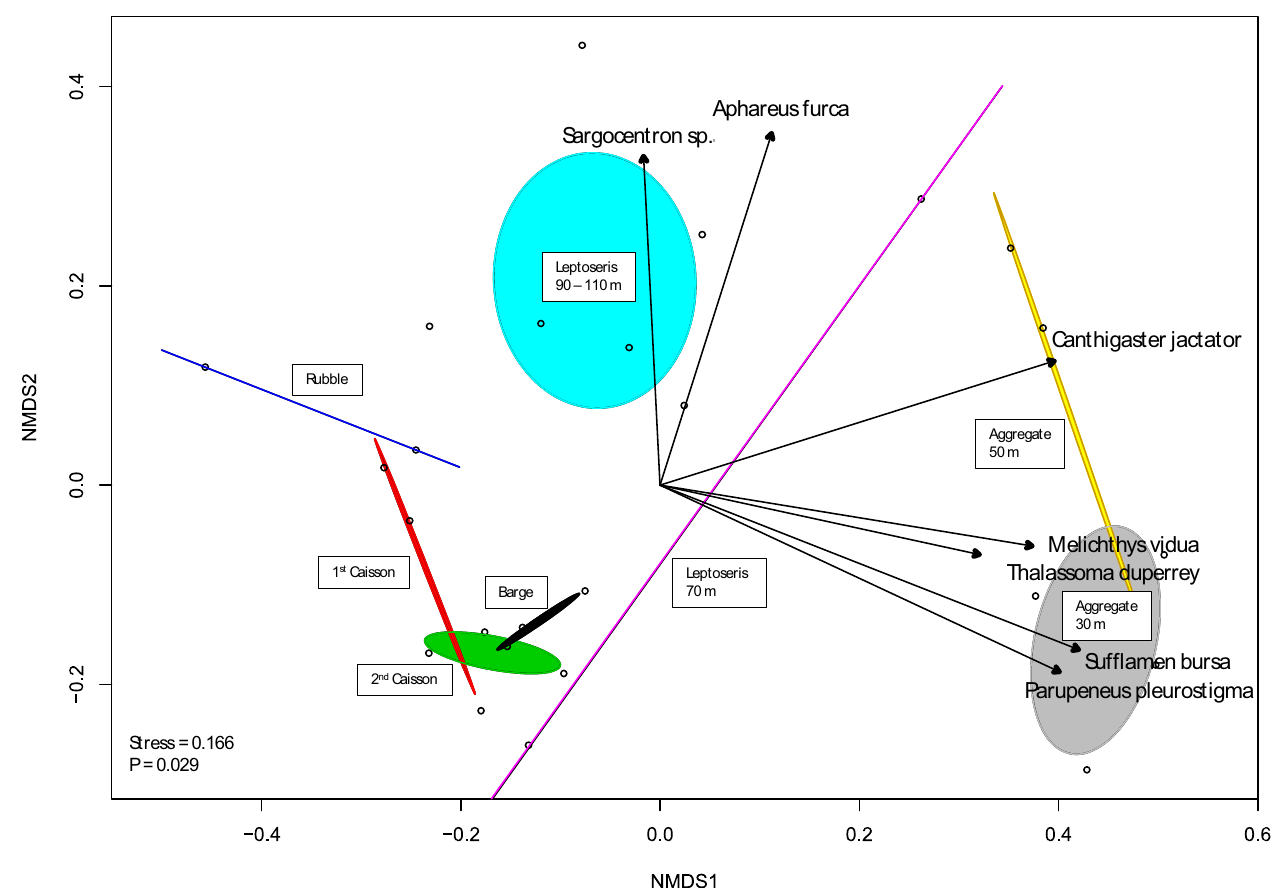
Fig 5. Vertical comparison of artifical and natural mesophotic reefs. nMDS analysis of the four shallower artificial features (93–117 m) compared to natural reefs at 90–110, 70, 50, and 30 m. Observations are grouped (colored ellipses) by feature (artificial substrates) or depth (natural substrates). Loadings of individual species are shown (dark gray) for species with very significant (p < 0.01) associations. https://doi.org/10.1371/journal.pone.0231668.g005 While the fish communities at the Ewa Beach artificial reef complex were diverse, they did not resemble those on natural substrates at similar depths (Fig 4). The Leptoseris reefs were dis- tinguished by a number of taxonomically- and trophically-diverse species which were rare or absent from artificial reefs, including Cirrhilabrus jordani , Centropyge potteri , and Myripristis chryseres . These biogenic reefs also had greater percentages of endemic and depth-generalist